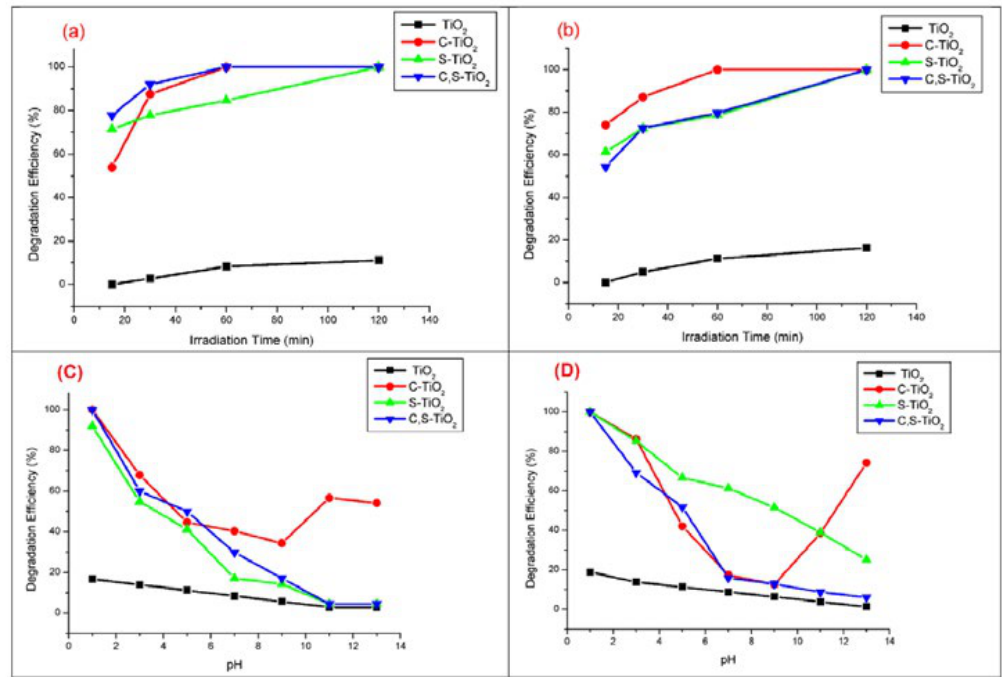
Fig. 6: Effect of irradiation time on RB-19 (a) and RR-76 (b) and pH on RB-19 (c) and of RR-76 (D) using the photocatalytic degradation efficiency present in industrial wastewater using TiO 2 , C-TiO 2 , S-TiO 2 and C,S-TiO 2 NPs photocatalysts.